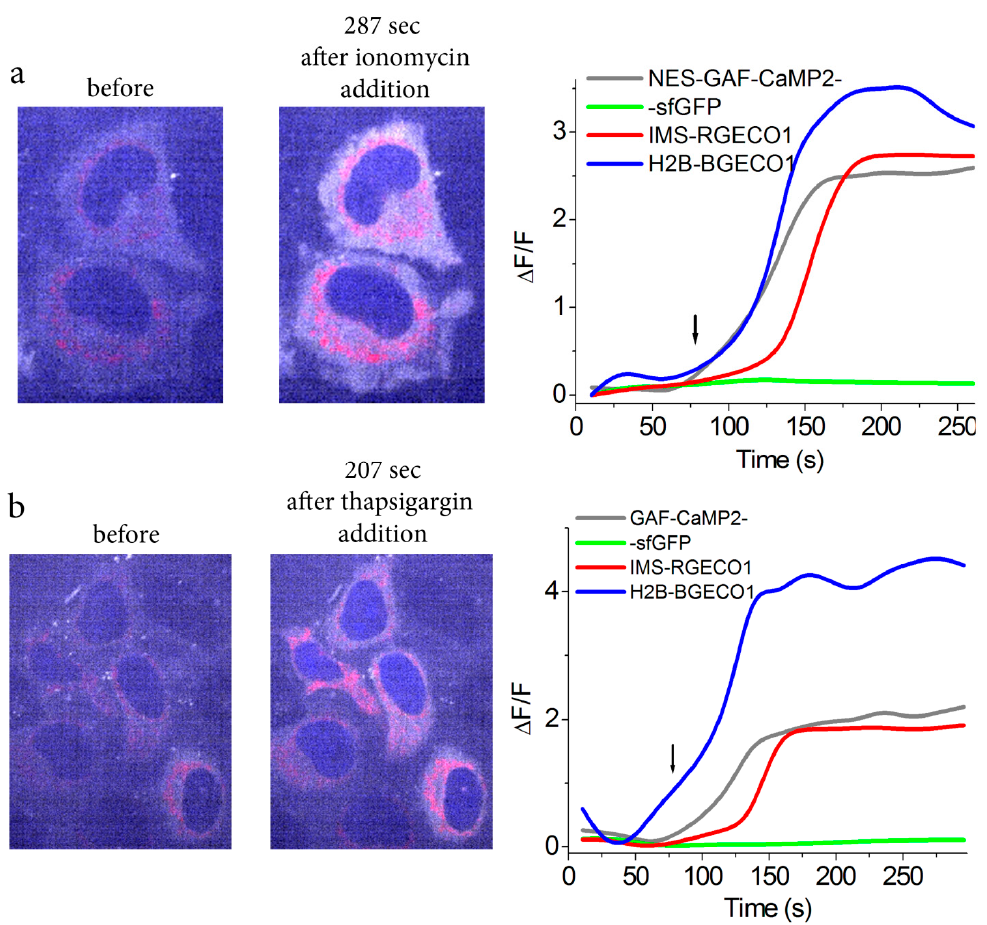
Figure 6. Visualization of calcium transients in three organelles of mammalian cells using GAF-CaMP2 indicator and four-color fluorescence confocal microscopy. Confocal images of HeLa Kyoto cells co-expressing blue H2B-B-GECO1, green / far-red NES-GAF-CaMP2-sfGFP, and red IMS-R-GECO1 calcium indicators in the nucleus, cytosol, and intermembrane space of mitochondria, respectively, before and respective time after addition of the 2.5 µ M ionomycin ( a ) or 10 µ M thapsigargin ( b ). Overlap images of blue (in blue, ex. 405 nm, em. 447 / 60 nm), red (in red, ex. 561 nm, em. 617 / 73 nm), and far-red (in grey, ex. 640 nm, em. 685 / 40 nm) channels are shown; the green (ex. 488 nm, em. 525 / 50 nm) channel is intentionally missed. The graphs illustrate ∆ F / F changes in all fluorescence channels for respective indicators. Example of one cell is shown. The time of ionomycin and thapsigargin addition is shown by the arrow. A total of 20 µ M BV was supplied during the cell’s transfection procedure 24–48 h before imaging.